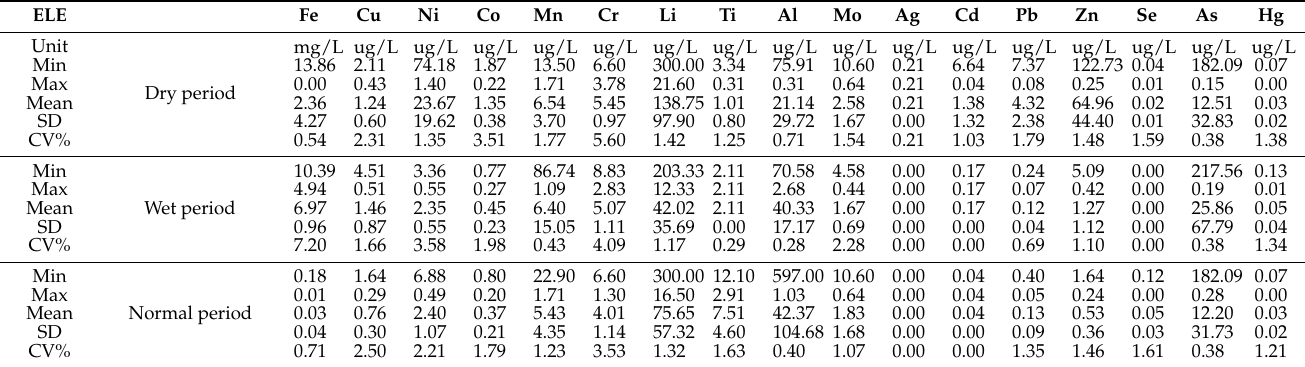
Table 2. Statistical characteristics of heavy metals in the Yarlung Tsangpo River basin during the dry, wet and normal periods ( N =